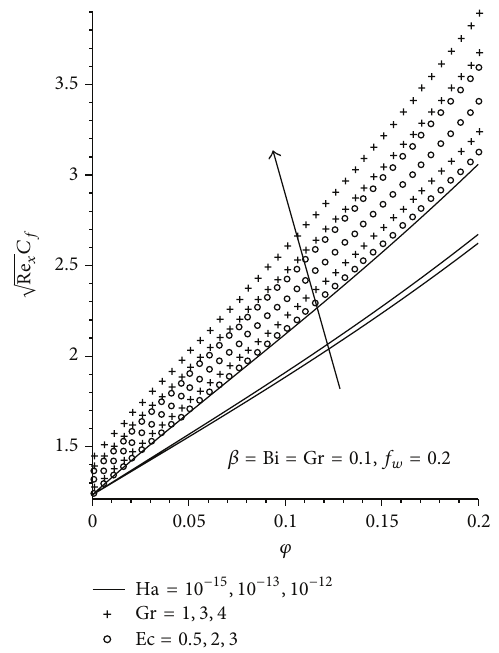
Figure 9: Effects of increasing Gr, Ha, and Ec on local skin friction.